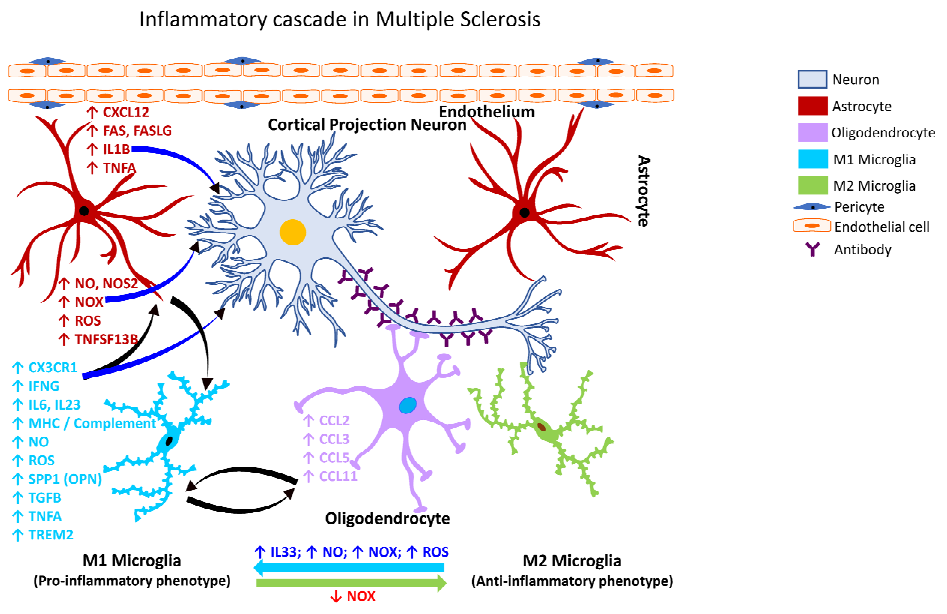
Figure 5. Inflammatory cascade in Multiple Sclerosis. Schematic representation of the molecular mechanisms associated with glia ‐ mediated functional interactions and systematic perturbations within the CNS to induce neuroinflammation in Multiple Sclerosis. The multifocal inflammatory demyelination of the white matter is driven largely by an inflammatory process besides an autoimmune component that involves innate and adaptive (B and T lymphocytes) immune cells. Various subtypes of myeloid cells are also critical for the pathogenic implications and the blood ‐ derived monocytes represent the highest fraction of infiltrating peripheral cells into the CNS that undergo transformation into monocyte ‐ derived inflammatory phagocytes (macrophages or dendritic cells) leading to neuronal damage. The endothelial cells form the inner lining of the blood vessel with pericytes enveloping the surface of the vasculature forming tight junctions to maintain the BBB integrity. Disruption of the BBB integrity further facilitates the infiltration of autoreactive immune cells into the CNS. Microglia serve as antigen presenting cells and present the myelin antigen to infiltrating B and T ‐ cells, thereby exacerbating the neuroinflammatory cascade. M1 microglia (proinflammatory phenotype, neurotoxic) release various proinflammatory mediators, including free radicals, cytokines, and chemokines that further stimulate other glial cells, thus perpetuating a self ‐ destructive environment that collectively contributes to exacerbating the neuronal injury/damage. M2 microglial cells (anti ‐ inflammatory phenotype, neuroprotective) can polarize to an M1 state and release proinflammatory mediators in the presence of increased levels of NOX, ROS, NO, and IL33 released by M1 microglia and/or astrocytes and thereby augment the neuroinflammatory and neuronal injury process leading to synaptic dysfunction, neuronal injury, and neuronal death. Astrocytes respond by releasing proinflammatory mediators, including free radicals, cytokines, and chemokines, which further contribute to enhancing the endothelial permeability, disrupting BBB integrity, and allowing for infiltration of peripheral immune cells, events that further intensify inflammation and neuronal injury. Feedback regulation of NOX or its inhibition causes M1 microglia to polarize to the M2 state (anti ‐ inflammatory phenotype), which downregulates M1 functions and promotes regulation of neuroinflammation and neurorepair by releasing anti ‐ inflammatory mediators, e.g., cytokines, neurotrophic, and growth factors. Mediators released by specific neural cell types (neuron, astrocyte, microglia or oligodendrocyte) are listed adjacent to each cell type in similar colored text. Curved arrows indicate the direction of signal flow between various neural cells for the inflammation activation process. Red curved arrows show the directional flow of danger/damage signals from neurons to glial cells (astroglia, microglia, oligodendroglia); blue curved arrows show the flow of proinflammatory signals from astrocytes and M1 microglia towards distressed neurons; green curved arrows show the flow of neurotrophic signals from M2 microglia and oli ‐ godendroglia towards the distressed neurons as a neuroprotective/neurorescue endeavor; black curved arrows show the directional crosstalk among various glial cells to mount a glial response to neuronal injury/damage. ↑ , increase; ↓ , decrease; BBB, blood ‐ brain barrier; CCL2, C ‐ C motif chem ‐ okine ligand 2 (also referred to as MCP1, monocyte chemoattractant protein 1); CCL3, C ‐ C motif